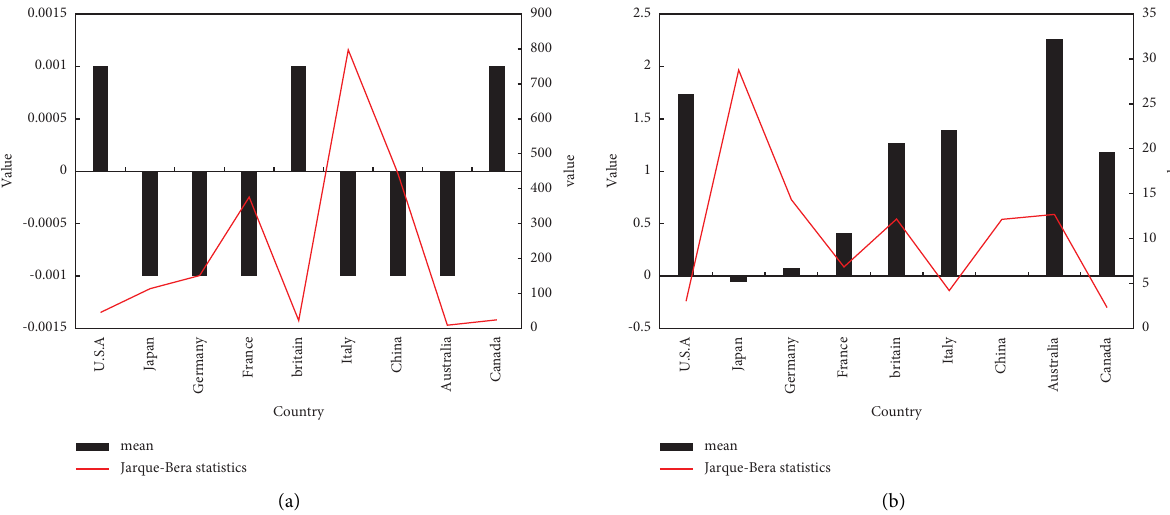
Figure 5: Descriptive statistics on the daily yield series of stock markets and government bonds of various countries: (a) stock market yields in various countries; (b) yields of national government